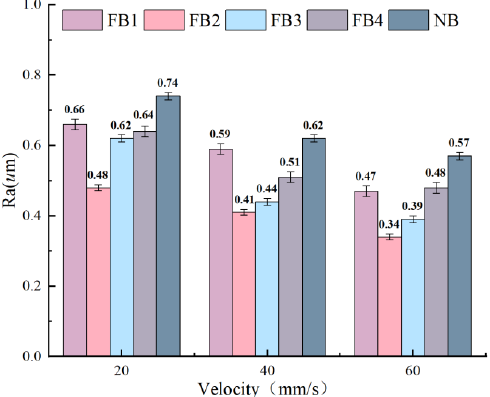
Figure 14. Roughness of the machined surface at different cutting speeds.